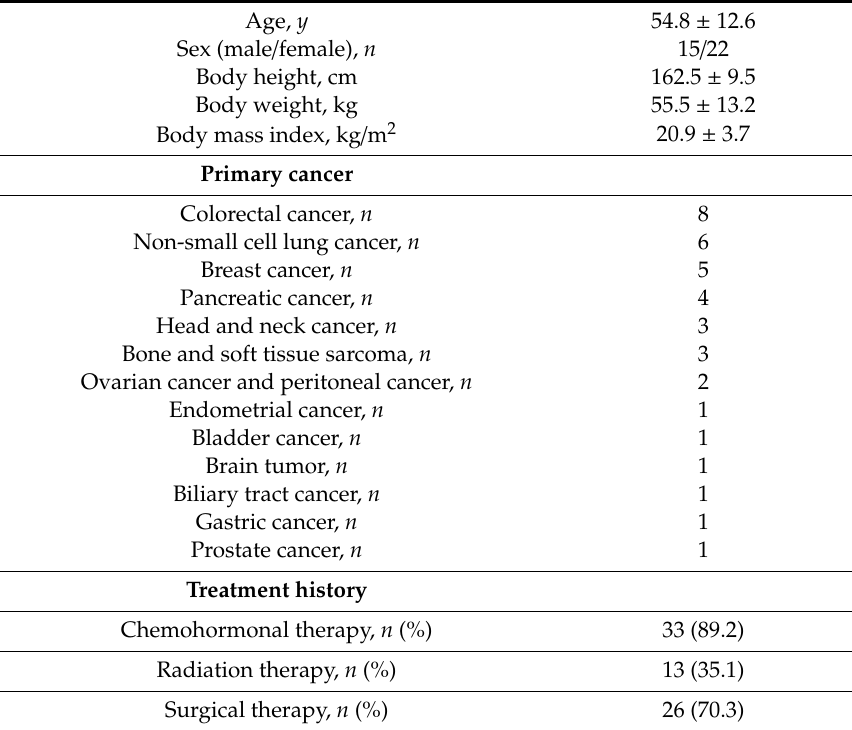
Table 1. Background of evaluable patients ( n =